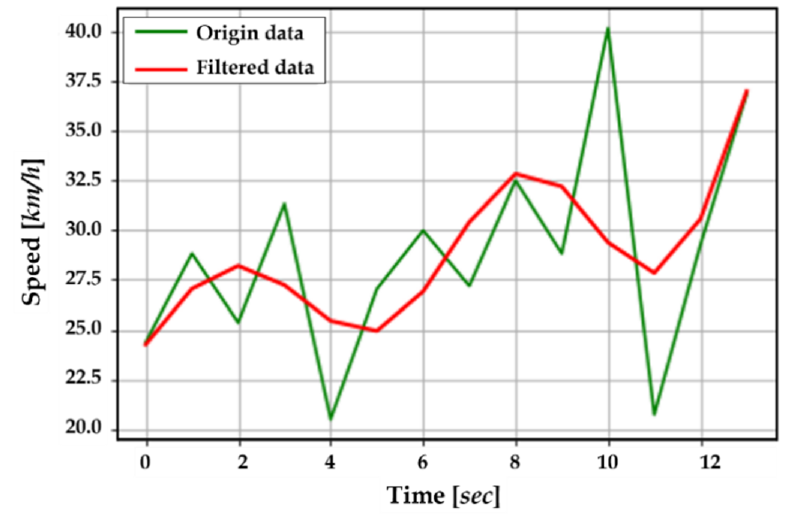
Figure 7. The origin speeds (green line) and the filtered data (red line).